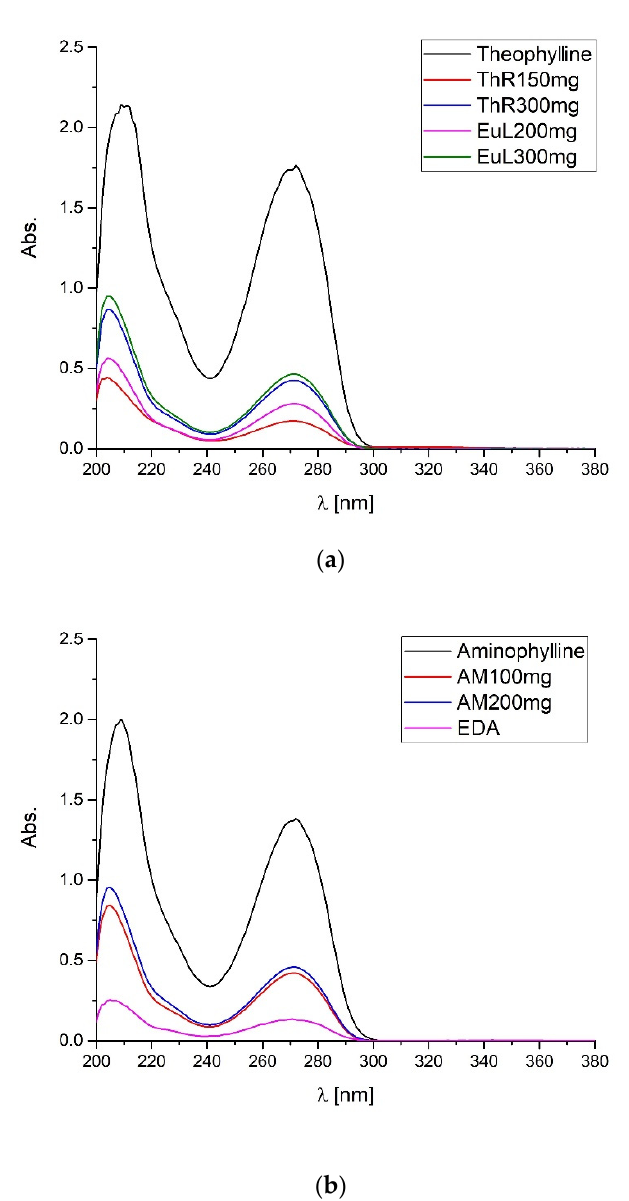
Figure 7. UV spectra in the wavelength range 200–380 nm of ( a ) theophylline standard, and pharmaceutical preparations containing theophylline: ThR (Theospirex ® retard 150 mg, 300 mg), EuL (Euphyllin ® long 200 mg, 300 mg), and ( b ) aminophylline standard, ethylenediamine hydrochloride standard, and pharmaceutical preparation containing aminophylline: AM (Aminophylline 100 mg, 200 mg).